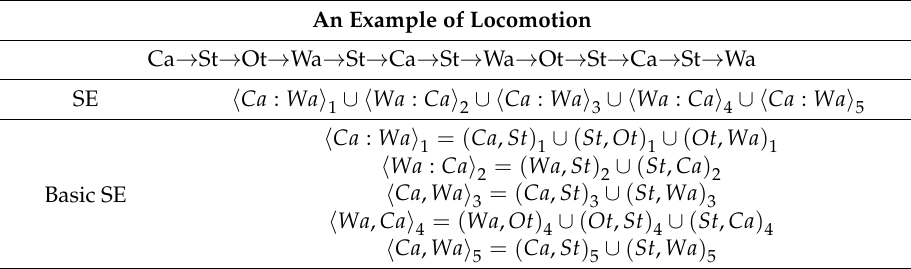
Table 7. Multistate-event experiment.